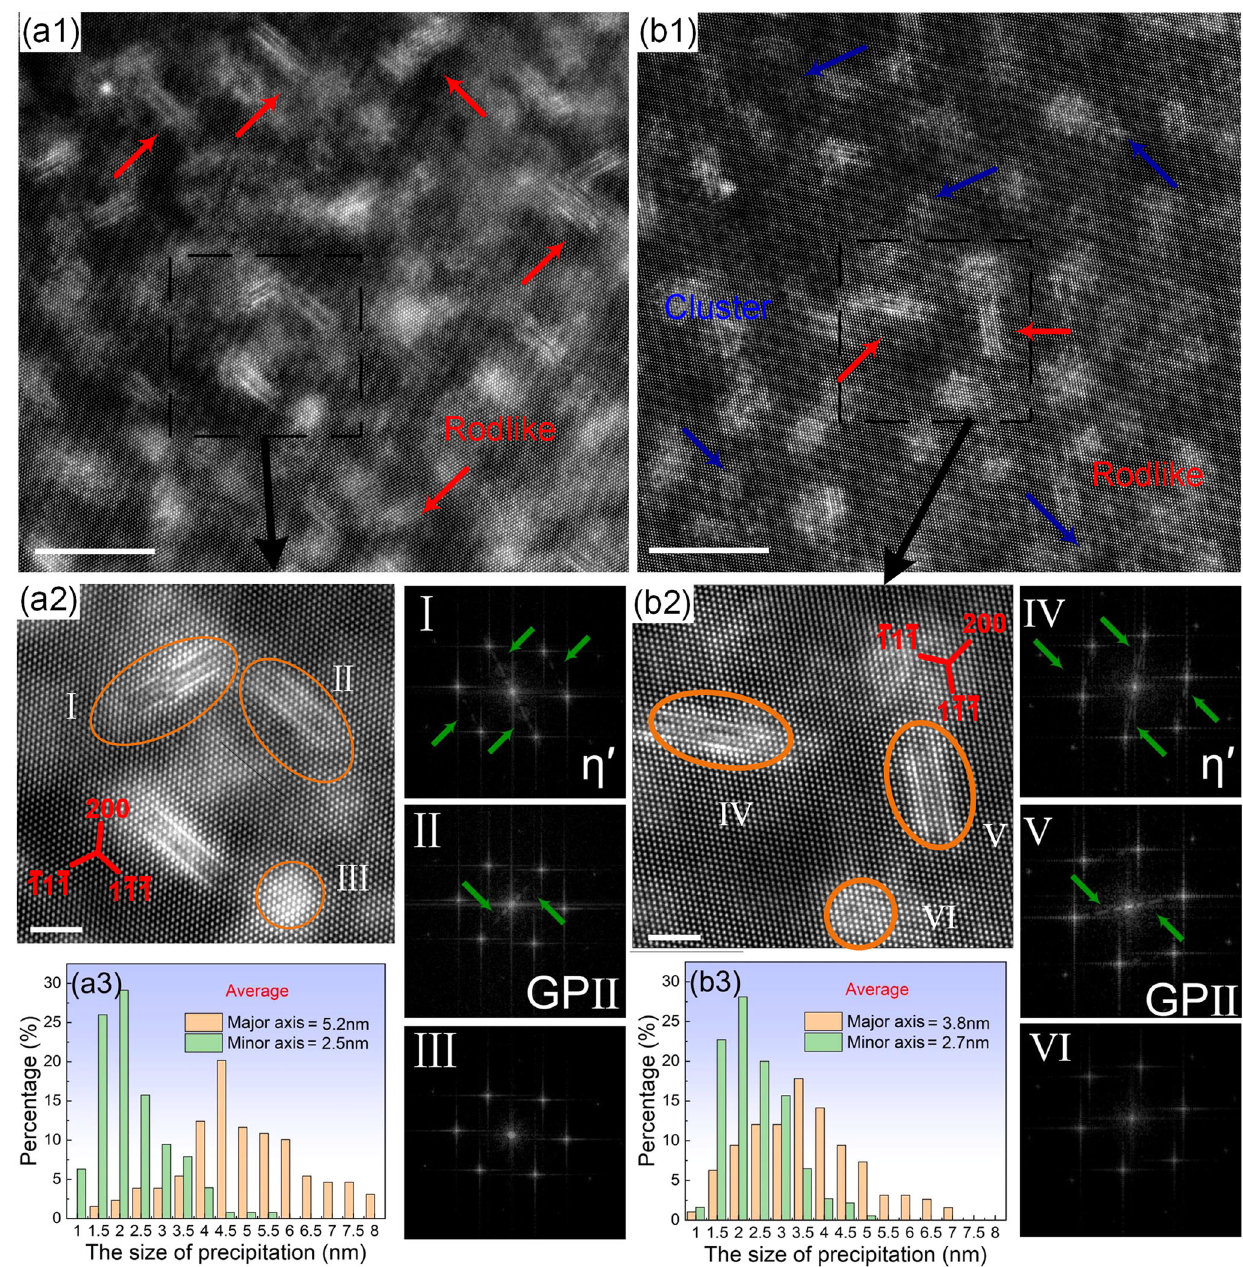
Fig. 7 The morphology and size statistics of matrix precipitates of the HT0 and T66R processes treated samples observed along the direction [011]. a 1 Low-magni fi cation morphology of precipitates in the HT0 sample (red arrow refers to rod precipitates, green arrow refers to disk precipitates); a 2 High-magni fi cation morphology of precipitates in the HT0 sample; a 3 The size of precipitates in the HT0 sample; b 1 Low-magni fi cation morphology of precipitates in the T66R sample (red arrow refers to rod-shaped precipitates, green arrow refers to disk- shaped precipitates, and blue arrow refers to atomic clusters); b 2 High-magni fi cation morphology of precipitates in the T66R sample; b 3 The size of precipitates in the T66R sample. Scale bars: 10 nm ( a 1, b 1), 2 nm ( a 2, b